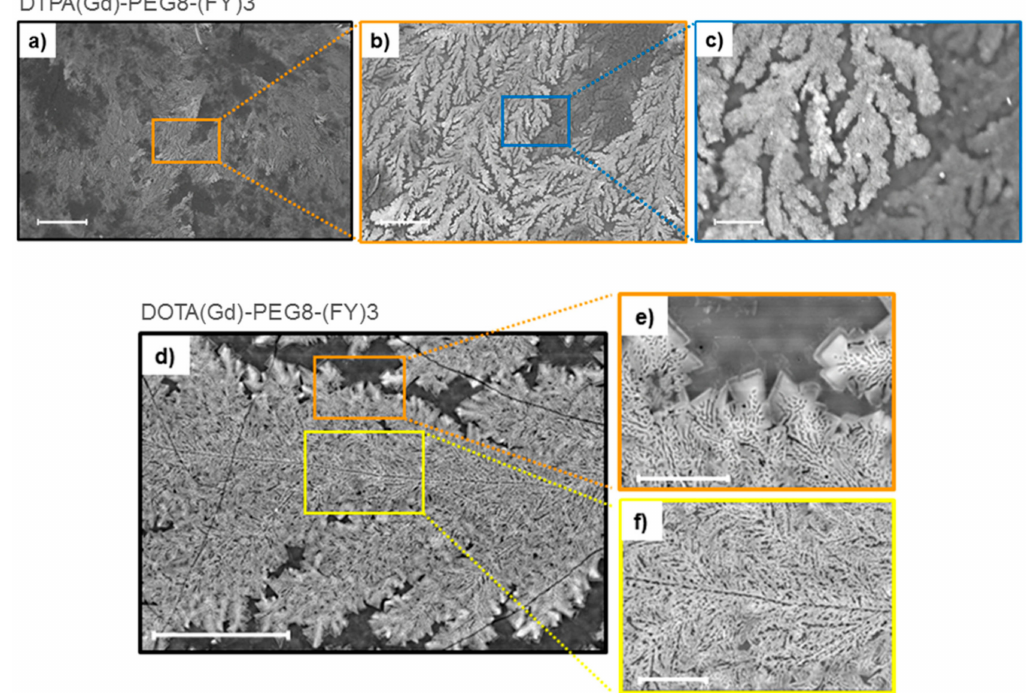
Figure 3. Selected SEM microphotos for DTPA(Gd)-PEG8-(FY)3 ( a , b , c ) and DOTA(Gd)-PEG8-(FY)3 ( d , e , f ) xerogels drop-casted from a solution at a concentration of 5 mg · mL − 1 : scale bars are 500 µ m ( a ), 100 µ m ( b ), 20 µ m ( c ), 50 µ m ( d ), 10 µ m ( e ), and 10 µ m ( f ),